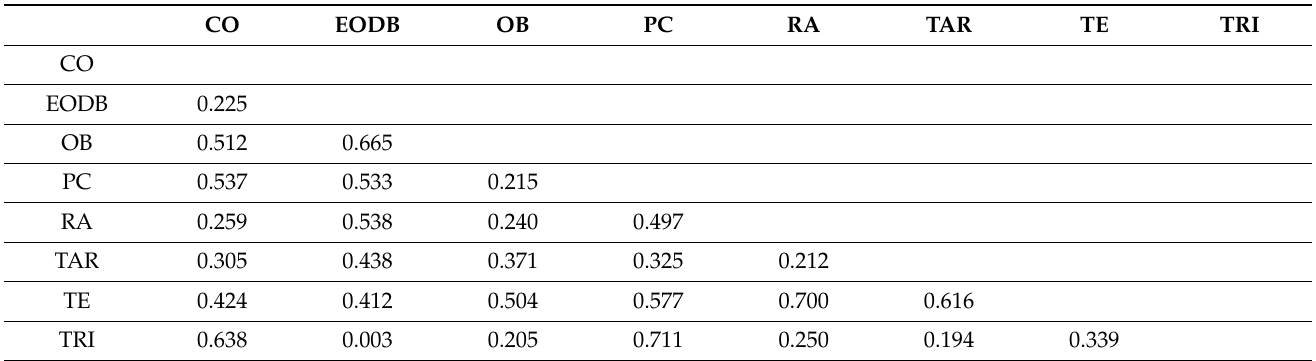
Table 7. Heterotrait–Monotrait Ratio (HTMT).